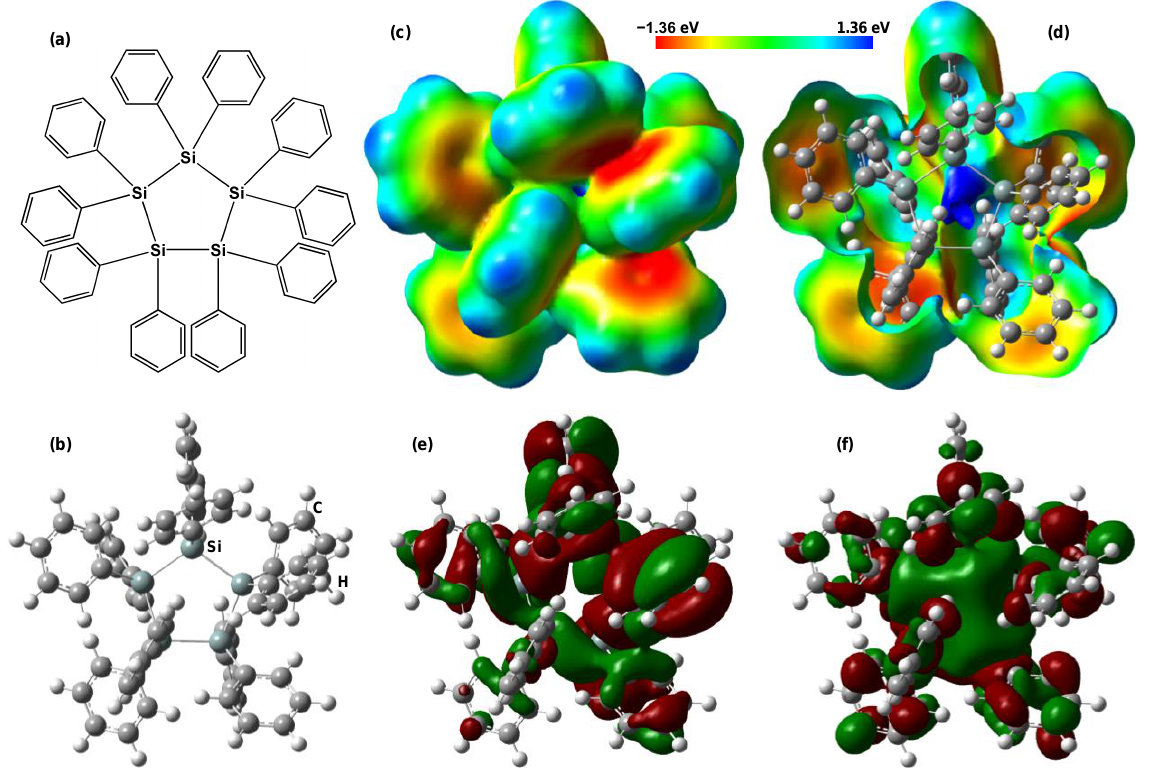
Figure 8. ( a ) Schematic and ( b ) optimized models of DPPS. ( c ) Electrostatic potential, ( d ) cutaway view of ( c ), ( e ) HOMO, and ( f ) LUMO.